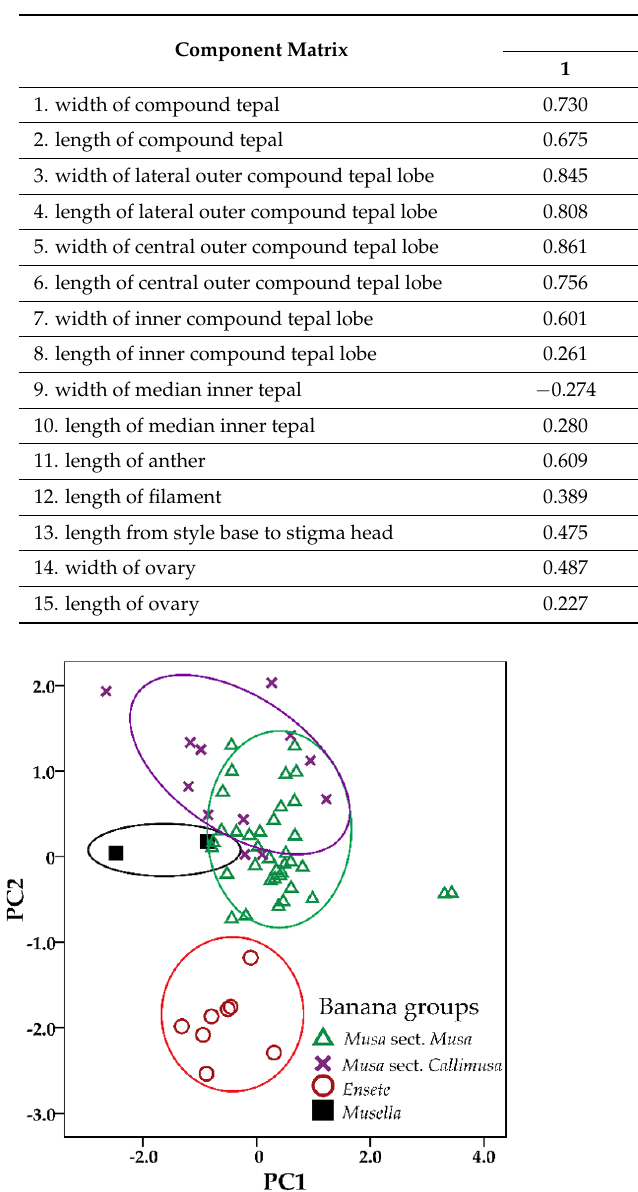
Table 2. Variable loadings in principal component analysis from 15 male floral morphological characters of Musa , Ensete and Musella . Loading higher than 0.7 are marked with bold type face.